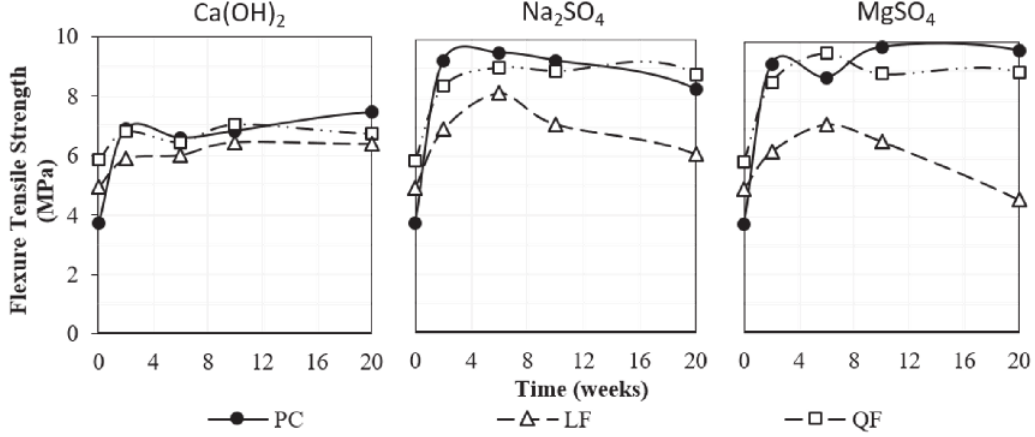
Flexural Tensile strength of the samples up to 20 weeks of exposure in the three different solutions [Ca(OH) , Na SO and MgSO ] 2 2 4 4